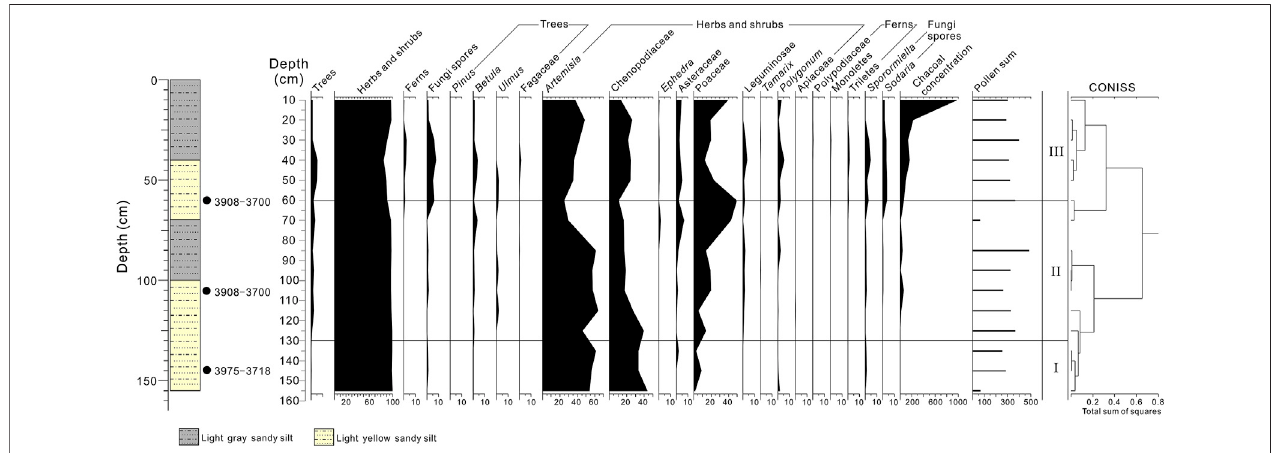
FIGURE 4 | Pollen percentage diagram for the ZKG section (only the major taxa are shown). The contents of fungal spores and charcoal particles are also shown.